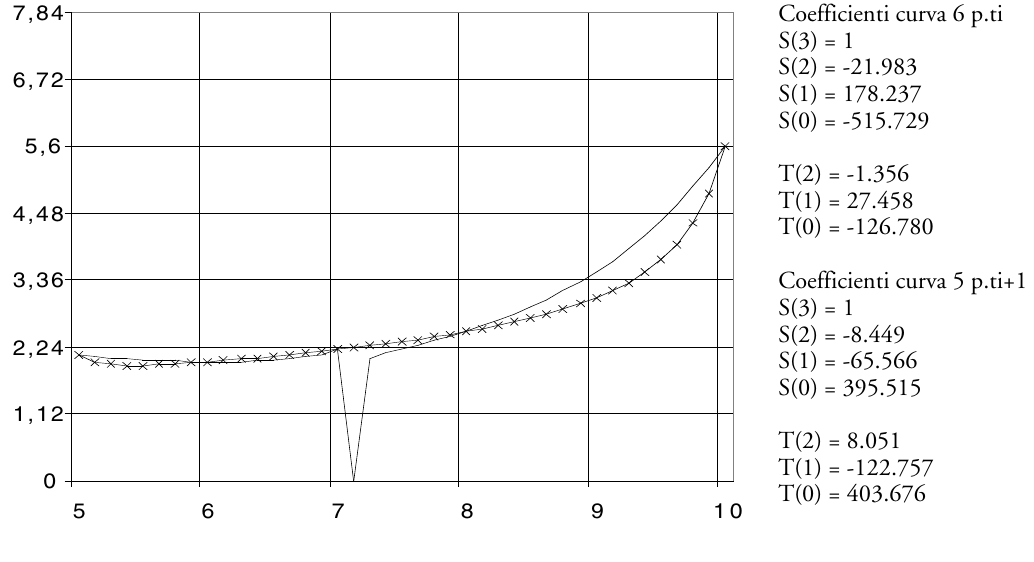
il 10-10-97 in MI Figura 7 – Rilevazione di CO 2 3 La curva in linea continua passa per i 6 punti dati, con discontinuità non eliminabili; quella a crocette passa per gli stessi punti escluso il quinto ed è continua, avendo eliminato le